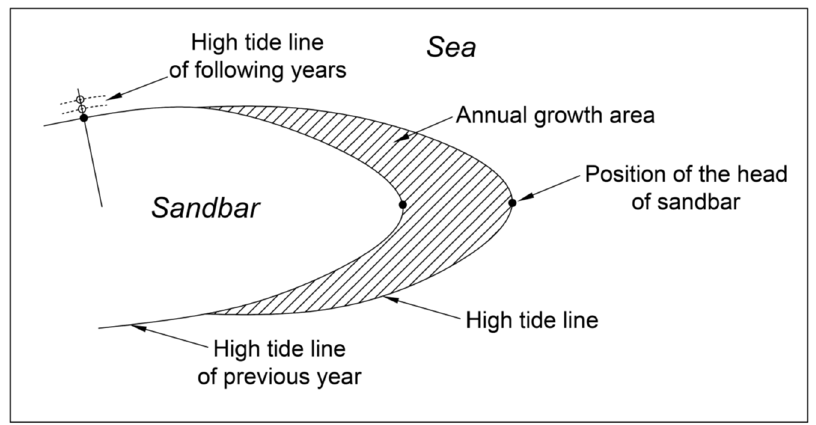
Figure 3. Schematic diagram of determining method of geomorphic parameters.